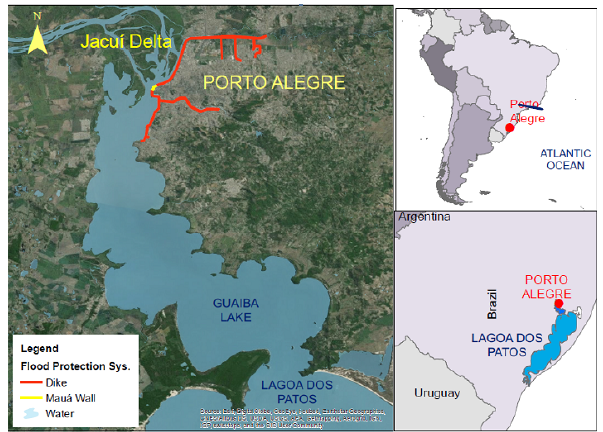
Figure 1. Maximum recorded flood levels at Guaiba Lake (1899 to 2013).